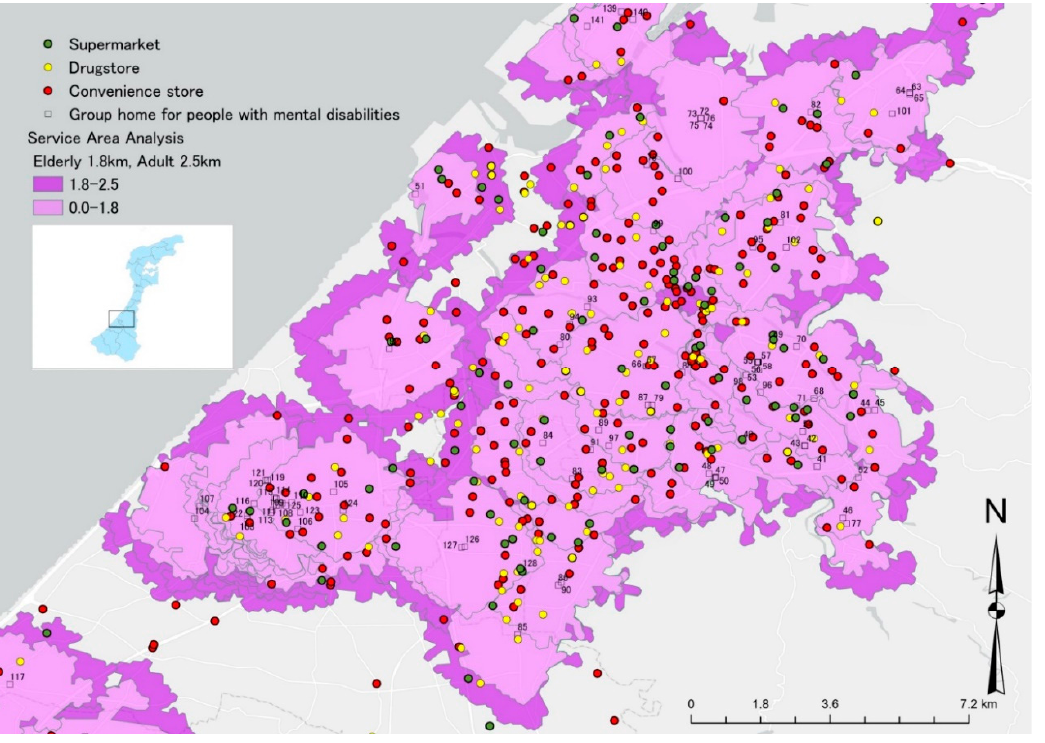
Figure 5. Geographical distribution of GHs and SPs in ELA in Kanazawa City, Nonoichi City, and Hakusan City.